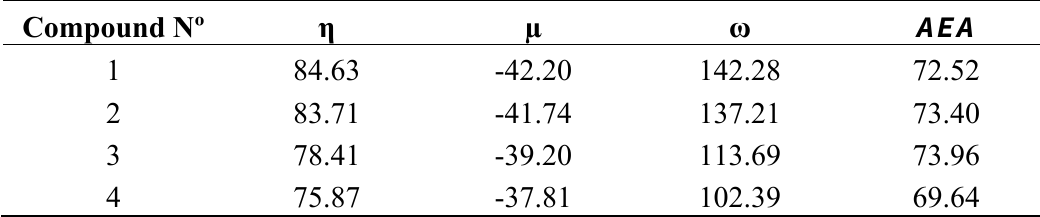
Table 1. Reactivity Indexes; chemical hardness ( η ), electronic chemical potential ( µ ), electrophilicity ( ω ) and the adiabatic electron affinities ( AEA ). Values are given in